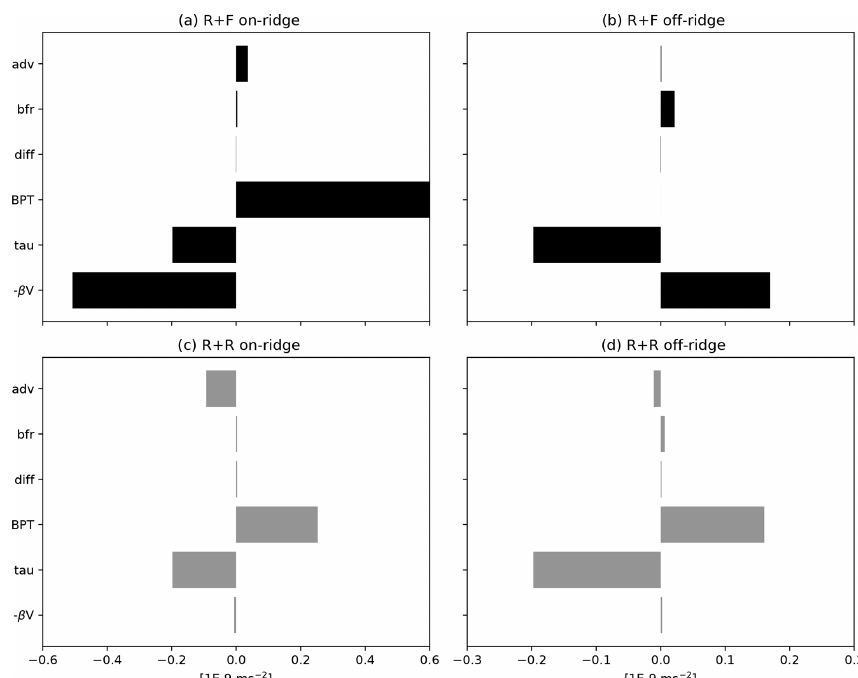
Figure 10. Depth-integrated mean barotropic vorticity balance (10 − 9 ms − 2 ) averaged between y = 400 and y = 600km for two zonal portions of the domain: (a, c) one under direct influence of the ridge (between x = 1500 and 2500km) and (b, d) one including the rest of the zonal domain. The different terms are as follows: the advection of planetary vorticity ( − βV ), the wind stress curl (tau), the bottom stress curl (bfr), the bottom pressure torque (BPT), the diffusion (which includes the effects of the lateral diffusion and Asselin time filter) and the nonlinear advection of vorticity